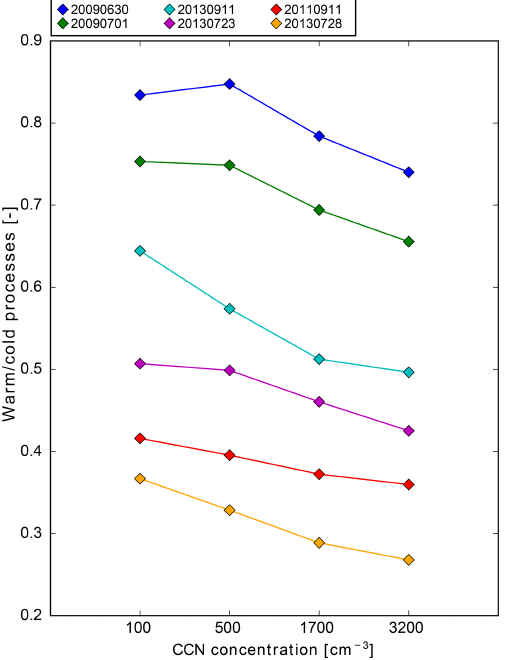
Figure 11. Ratio between warm (autoconversion and accretion) and cold (vapor deposition and riming) rain processes as a function of the CCN